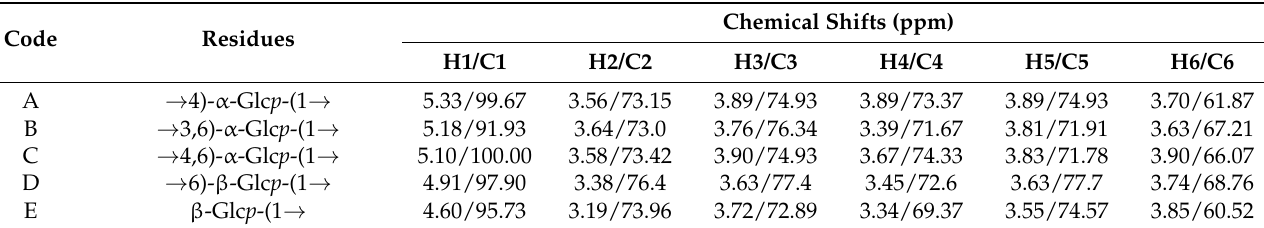
Table 3. Chemical shifts of main residues of GEP-1 .